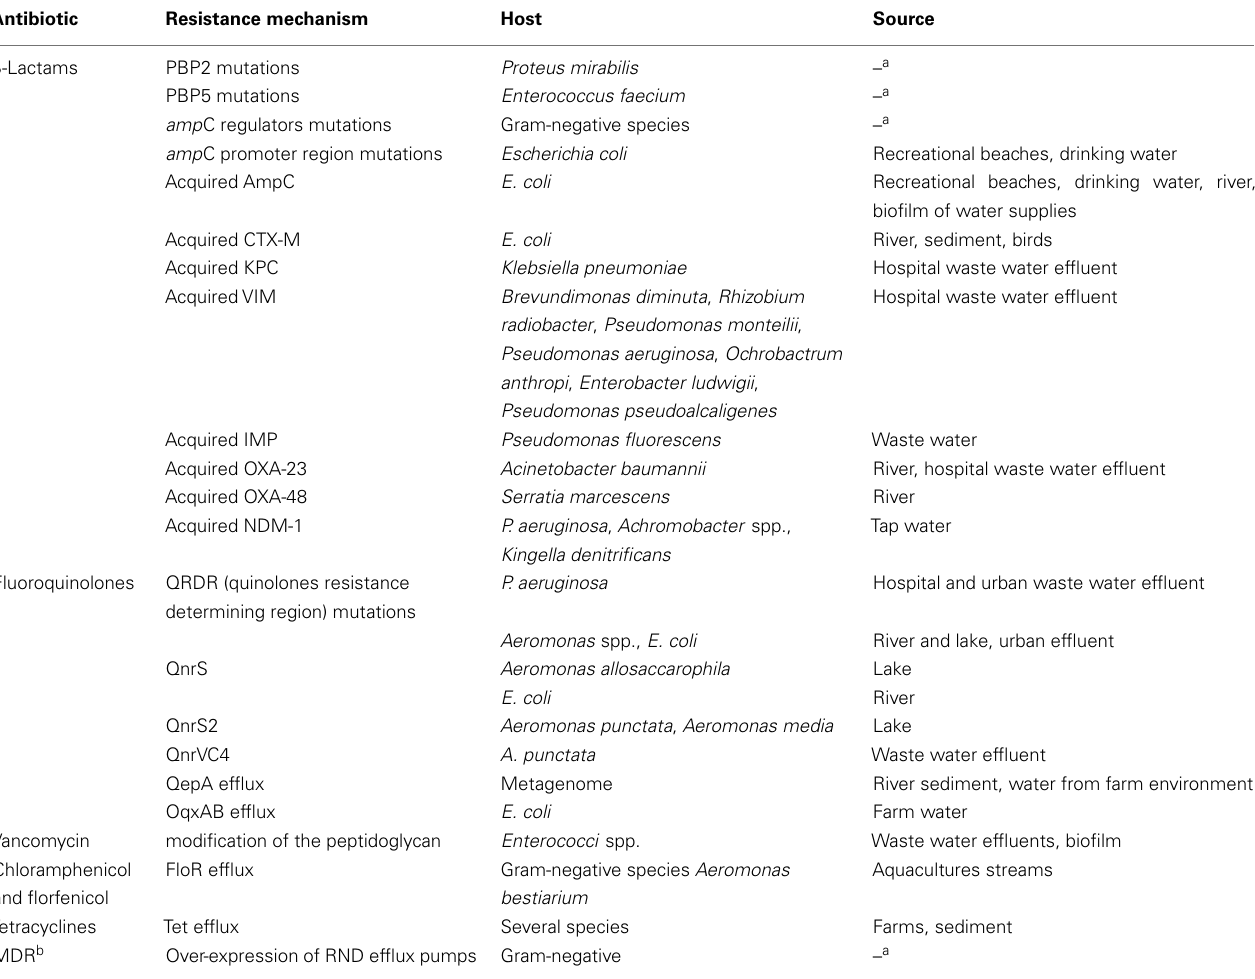
Table 1 | Overview of some mechanisms of bacterial antibiotic resistances occurring in water